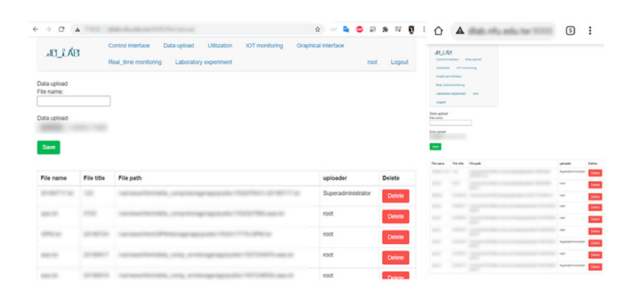
Figure 15. File-upload interface.